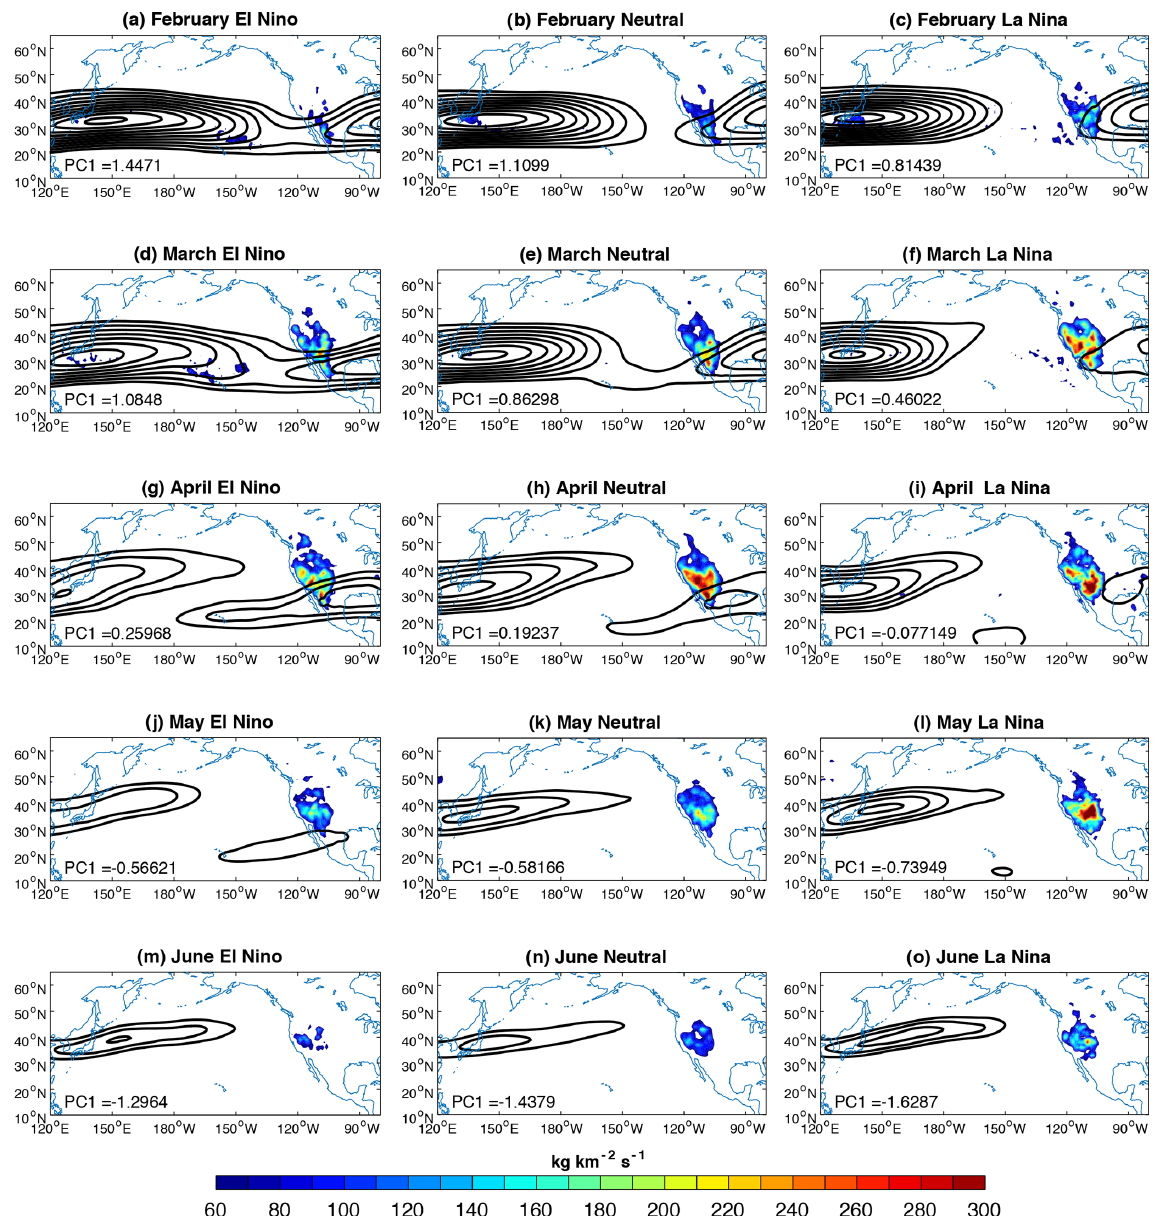
Figure 9. The color shading shows the monthly mean STT-PBL during El Niño conditions (left), ENSO-neutral conditions (middle), and La Niña conditions (right). The black contours show the monthly mean 200hPa zonal wind. The mean PC1 values for each month and ENSO group are shown in the bottom left corner. Zonal wind contours start at 30ms − 1 at intervals of 5ms − 1